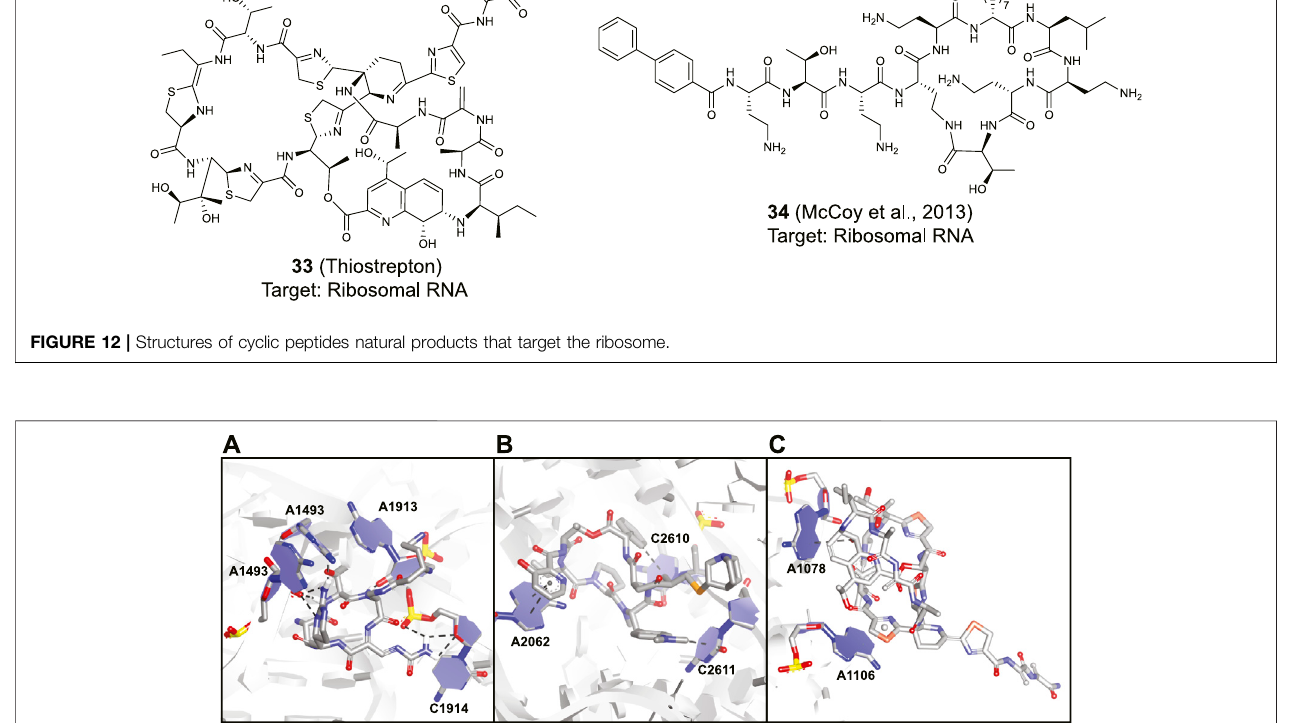
Frontiers in Molecular Biosciences |